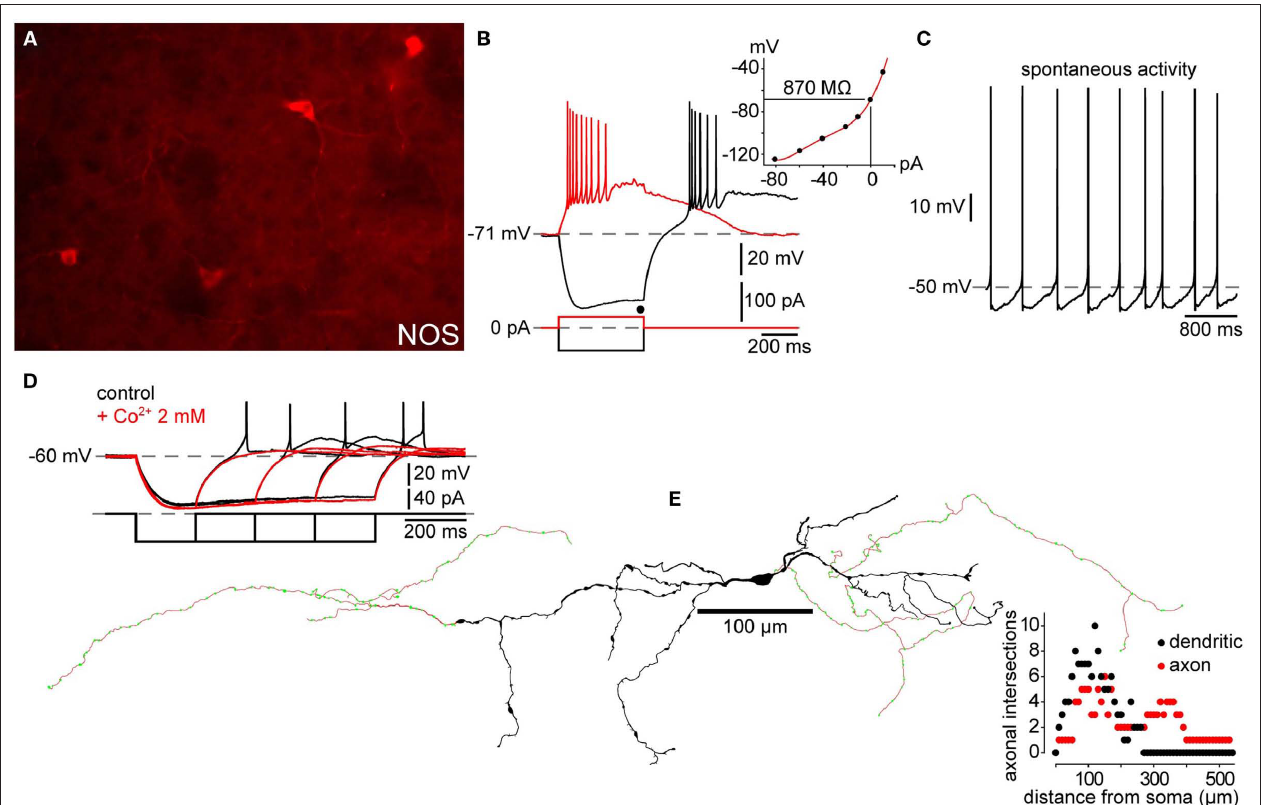
(B) shows typical high input resistance of striatal PLTS interneurons, even at FiGurE 3 | Electrophysiology and morphology of striatal SOM/NPY/NOS maximum of I interneurons. (A) Immunofluorescence photomicrograph of NOS + mouse striatal activation (black dot). (C) Spontaneous activity typical of many SOM/ h interneurons. (B) Passive electrophysiological properties of a NPY + interneuron from NPY/NOS interneurons. (D) Rebound depolarizations display the time dependent de-inactivation, all-or none nature and blockade by Co 2 + characteristic of a LTS. (E) a striatal slice from a BAC transgenic EGFP–NPY + mouse shows the characteristic relatively depolarized resting membrane potential, LTS following cessation of a Reconstruction of a biocytin filled PLTS interneuron shows typical varicose hyperpolarizing current injection (black trace), I and, prolonged depolarizing plateau h potentials elicited from rest by depolarizing current injection (red trace) and following the rebound LTS after a hyperpolarizing current injection. Inset: IV curve from data in